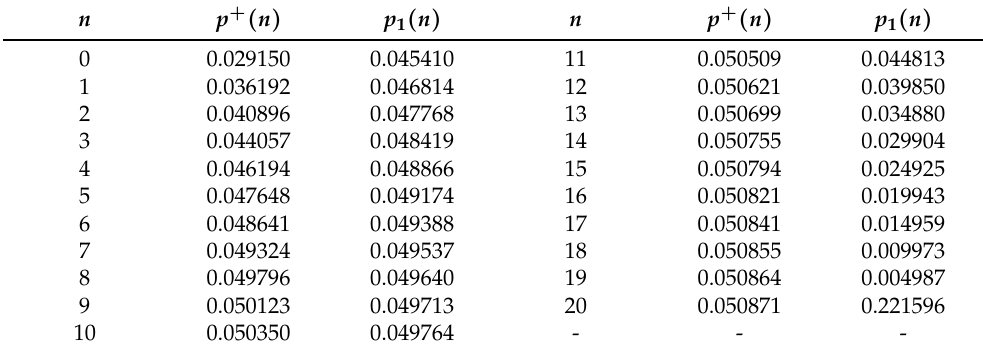
Table 5. Computation of post-departure epoch probabilities and random epoch probabilities